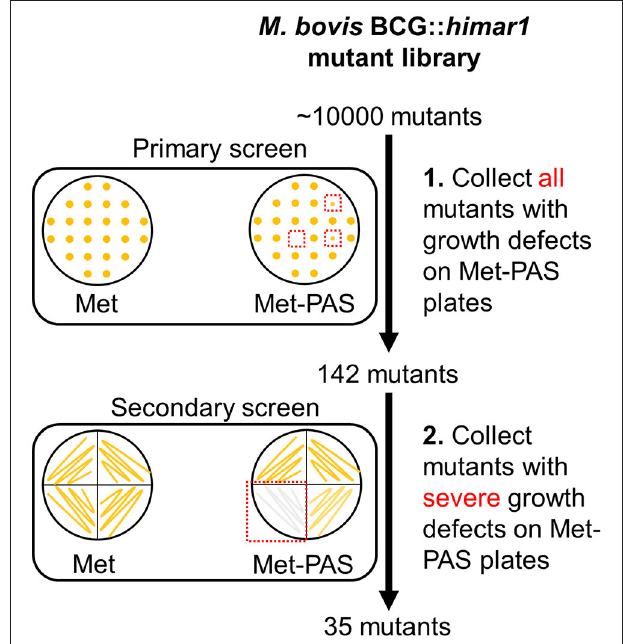
FIGURE 2 | Schematic representation of genome-wide transposon mutagenesis of M. bovis BCG and Met-PAS screening method. M. bovis BCG:: himar1 mutants ( ∼ 10,000 mutants) were patched onto Met and Met-PAS plates. Clones with observable growth defects on Met-PAS plates were subjected to secondary screening. These 35 mutants that passed the secondary screening were collected and insertion site locations were